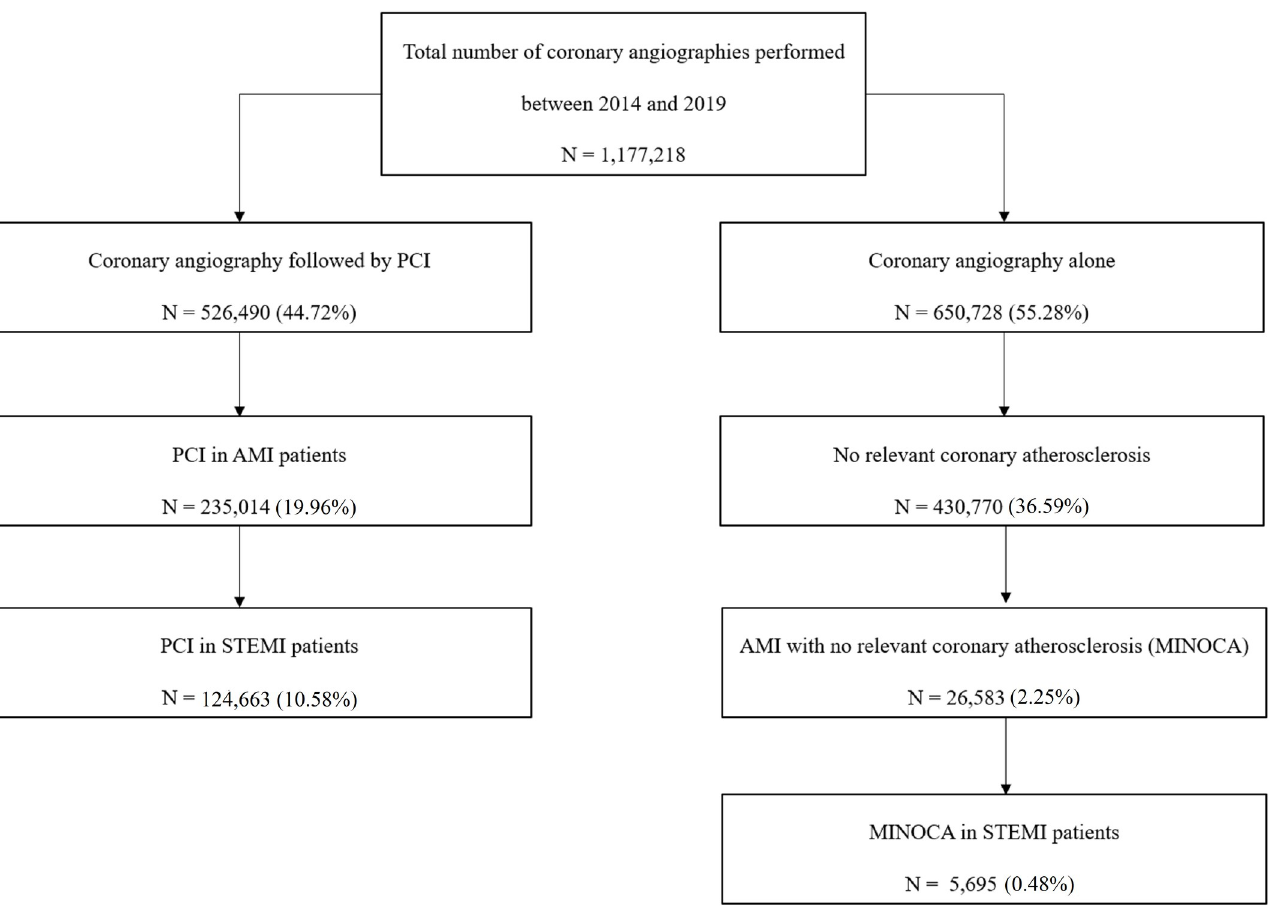
Fig 1. Patient flow